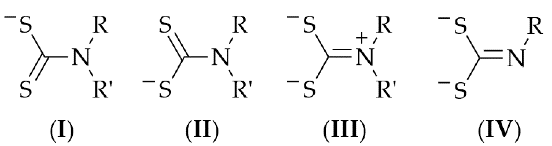
Figure 1. ( I – III ) Canonical forms of the dithiocarbamate mono-anion [R(R’)NCS 2 ] − , R/R’ = H, alkyl, and aryl and ( IV ) the electronic structure of the dithiocarbimate di-anion [(R)C=NCS 2 ] 2 − , R = CN, alkyl, and aryl.